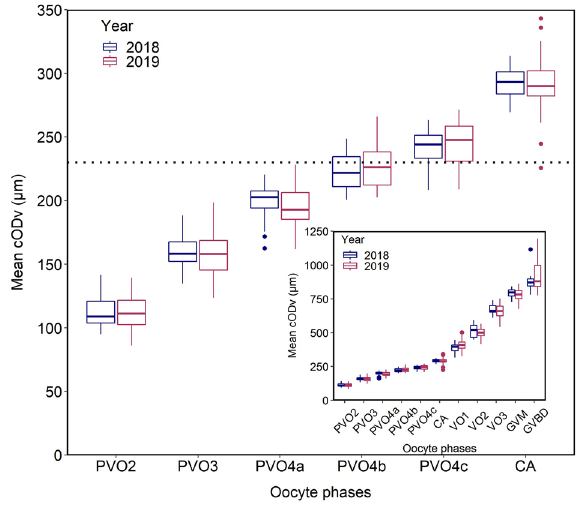
Figure 4. Mean oocyte size (cODν) by phase ( i ) during the spawning season (March to July). The insert shows the mean cODν for all oocyte phases, whereas the main plot presents a “zoom-in” on PVO2-4c and